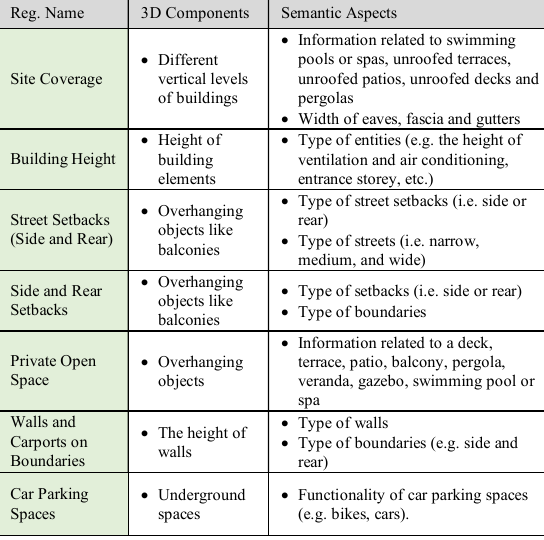
Table 1. Zoning and dimensioning